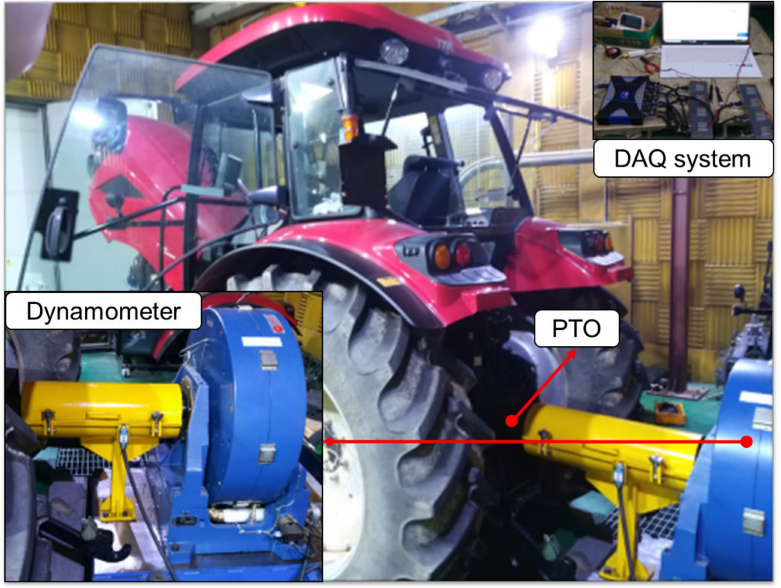
Figure 3. The PTO dynamometer test bench used in this study.